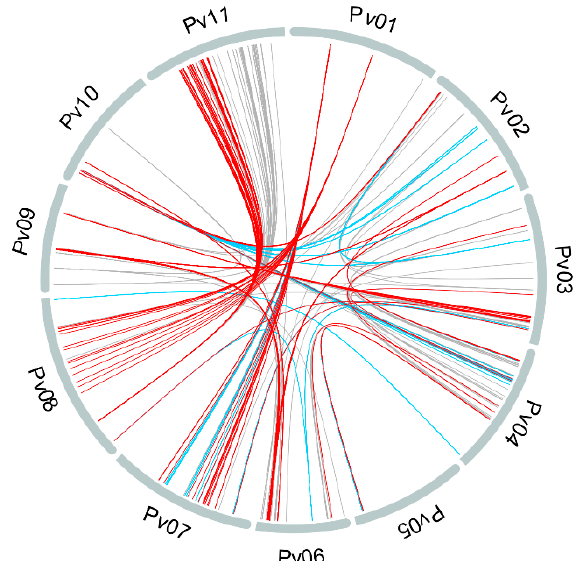
Figure 5. Inter-chromosomal linkage disequilibrium (LD) in Phaseolus vulgaris . Gray, blue, and red lines connecting chromosomes correspond to LD estimates between SNP pairs in which r 2 ≥ 0.7, 0.8, and 0.9, respectively.